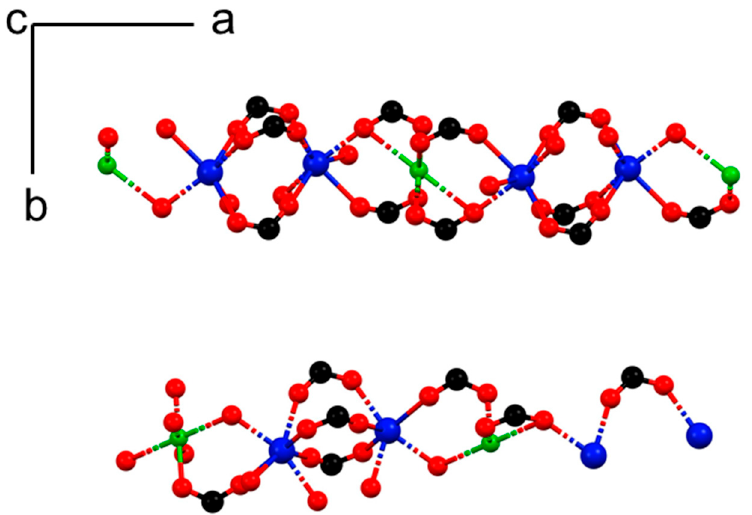
Figure 2 . View of the 1-D chain growing along the a-axis featured in the structure of Compound 1 . The colors for elements are as follows: gadolinium (blue), copper (green) oxygen (red), and carbon (black).